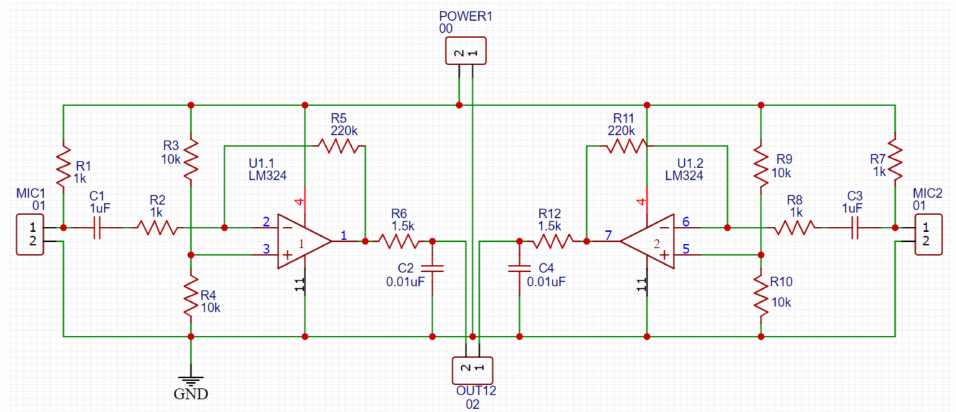
Figure 8. Schematic diagram of the power amplifier